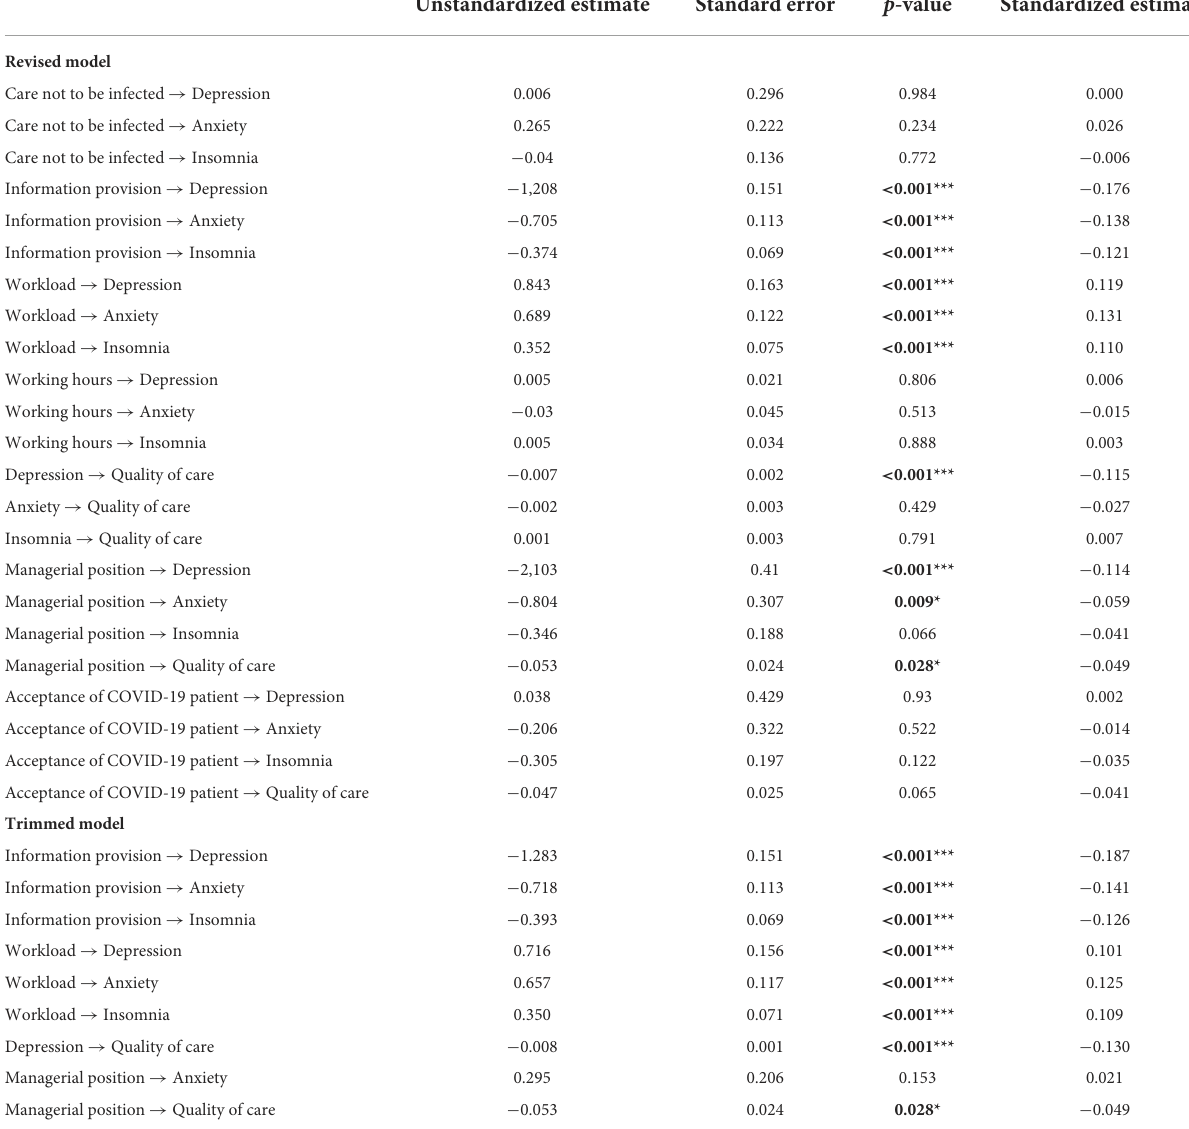
TABLE 3 Path coefficients of the revised model and trimmed model. Unstandardized estimate Standardized